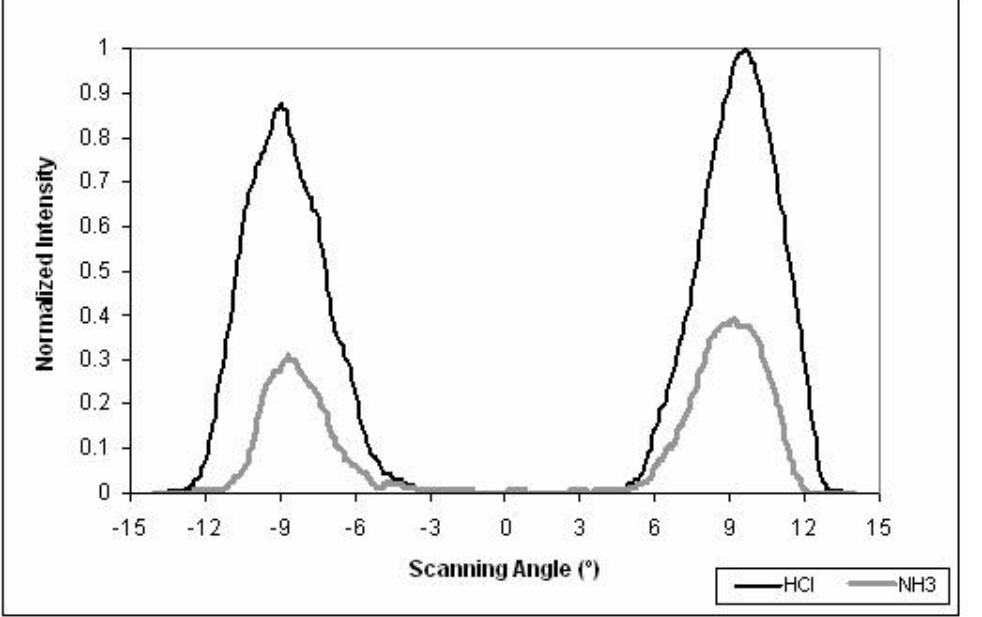
Figure 19. Normalized intensity profiles of the 2-D ring